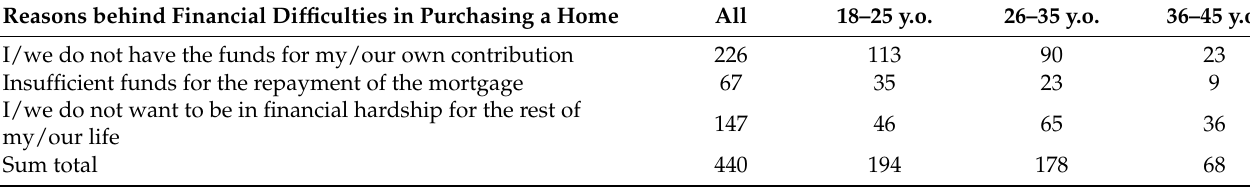
Table 6. Reasons behind financial difficulties in purchasing a